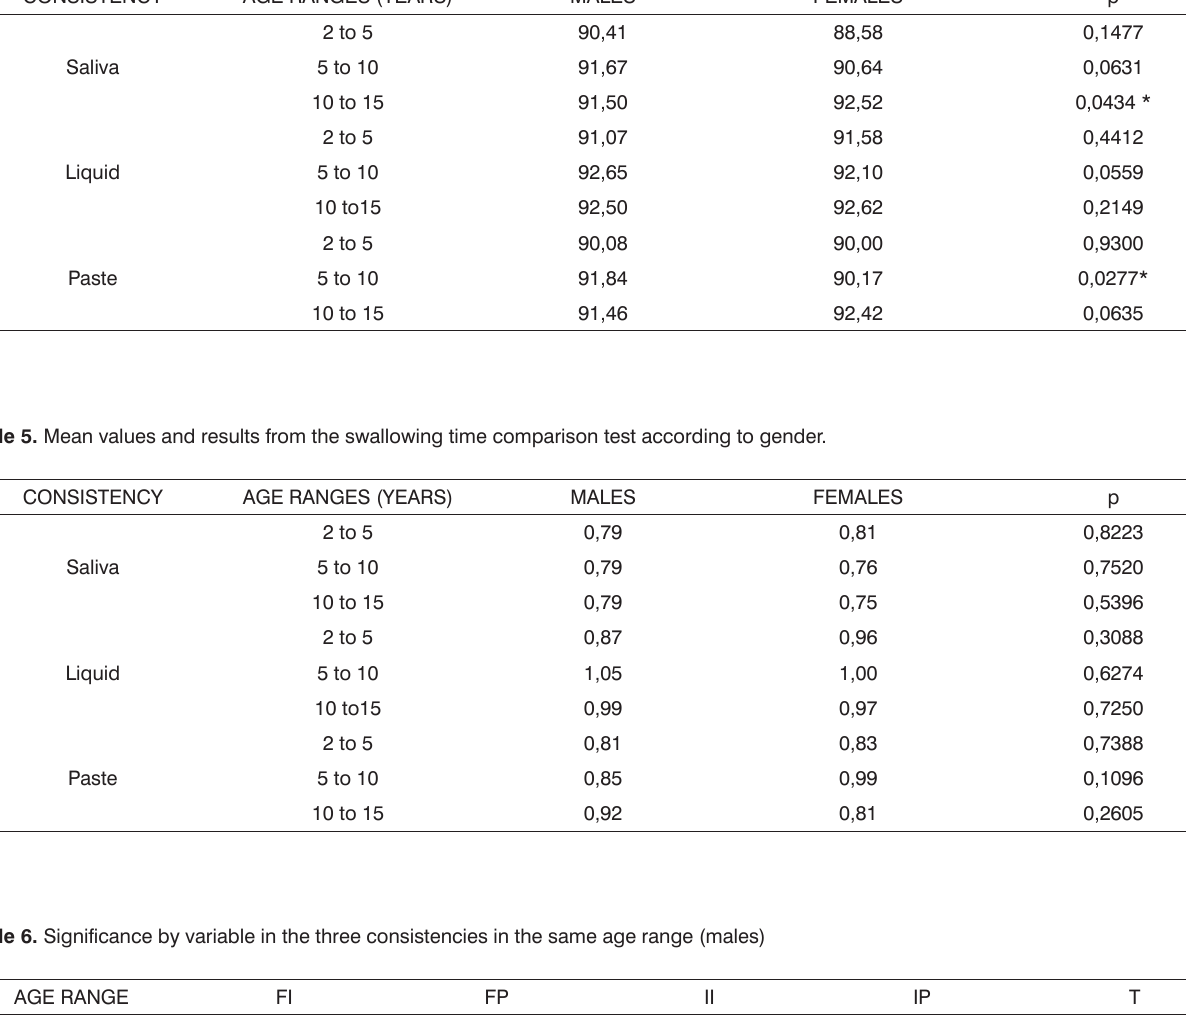
Table 4. Mean values and results from the peak intensity comparison tests according to gender. CONSISTENCY